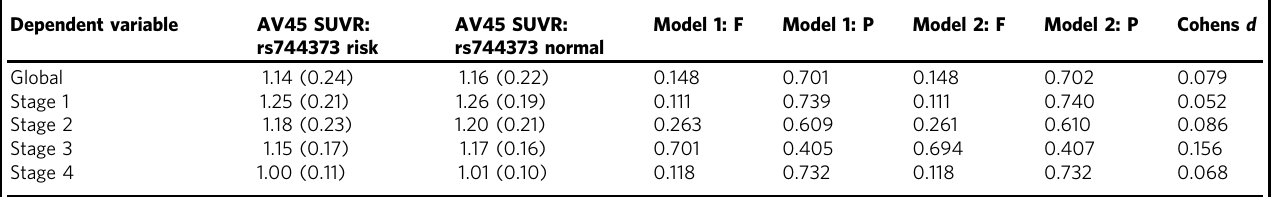
Table 3 BIN1 rs744373 risk allele as a predictor of AV45 amyloid-PET SUVR Dependent variable